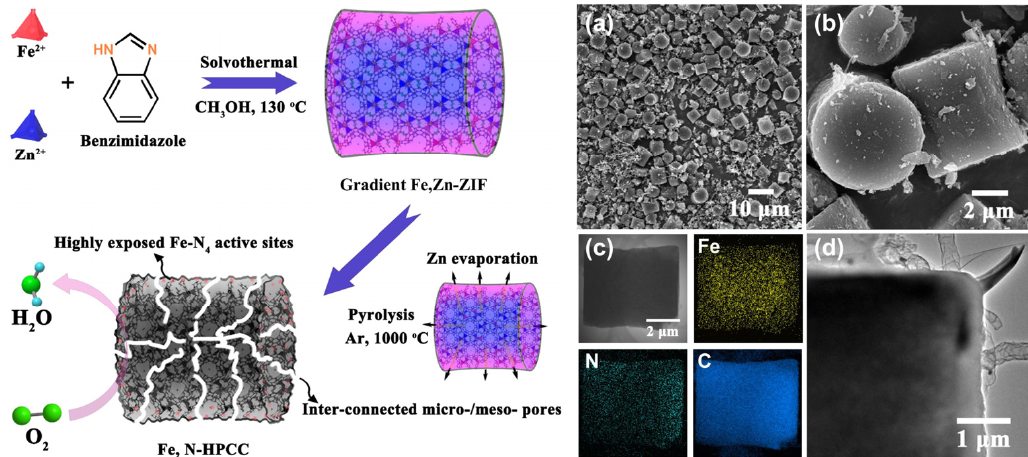
Figure 6. ( Left ) Schematic synthesis of a Fe- and N-co-doped hierarchically porous carbon cylinder catalyst denoted as Fe,N-HPCC. ( Right ) ( a , b ) SEM images, ( c ) STEM mappings of N, C, and Fe, and ( d ) TEM image of Fe,N-HPCC. Reprinted and modified with permission from ref. [83]. Copyright (2019)